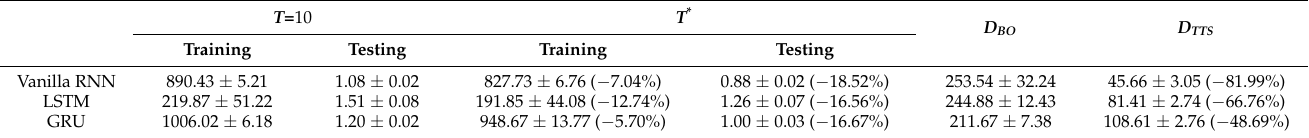
Table 3. Computation time of neural decoders using neural activity with T and T ∗ timesteps. The efficiency is given by the computation time (ms) required to complete one epoch of offline training and one online prediction. The reduced number of timesteps T ∗ of vanilla RNN, LSTM, and GRU were obtained from Figure 4, and the corresponding computation time was obtained over 37 sessions. The reduction in the computation time (in percentage) compared to that of T = 10 is shown in parentheses. D BO and D TTS represent the time duration (second) of the timesteps selection achieved by the Bayesian optimization and our TTS, respectively. The reduction of the time duration (in percentage) compared to that of the Bayesian optimization is shown in